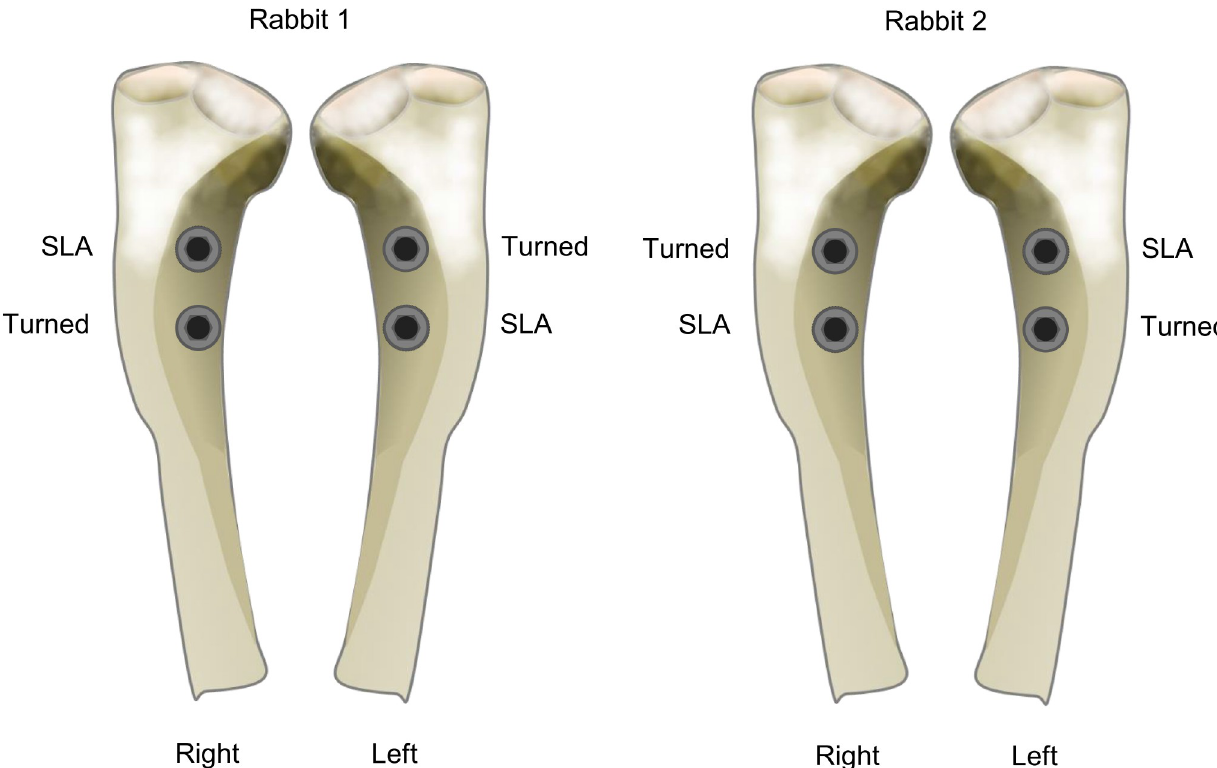
Fig 1. In vivo study design. Schematic illustration showing placement of the implants in the rabbit tibia model, considering complete randomization. SLA, sandblasted, large-grit, acid-etched implant.